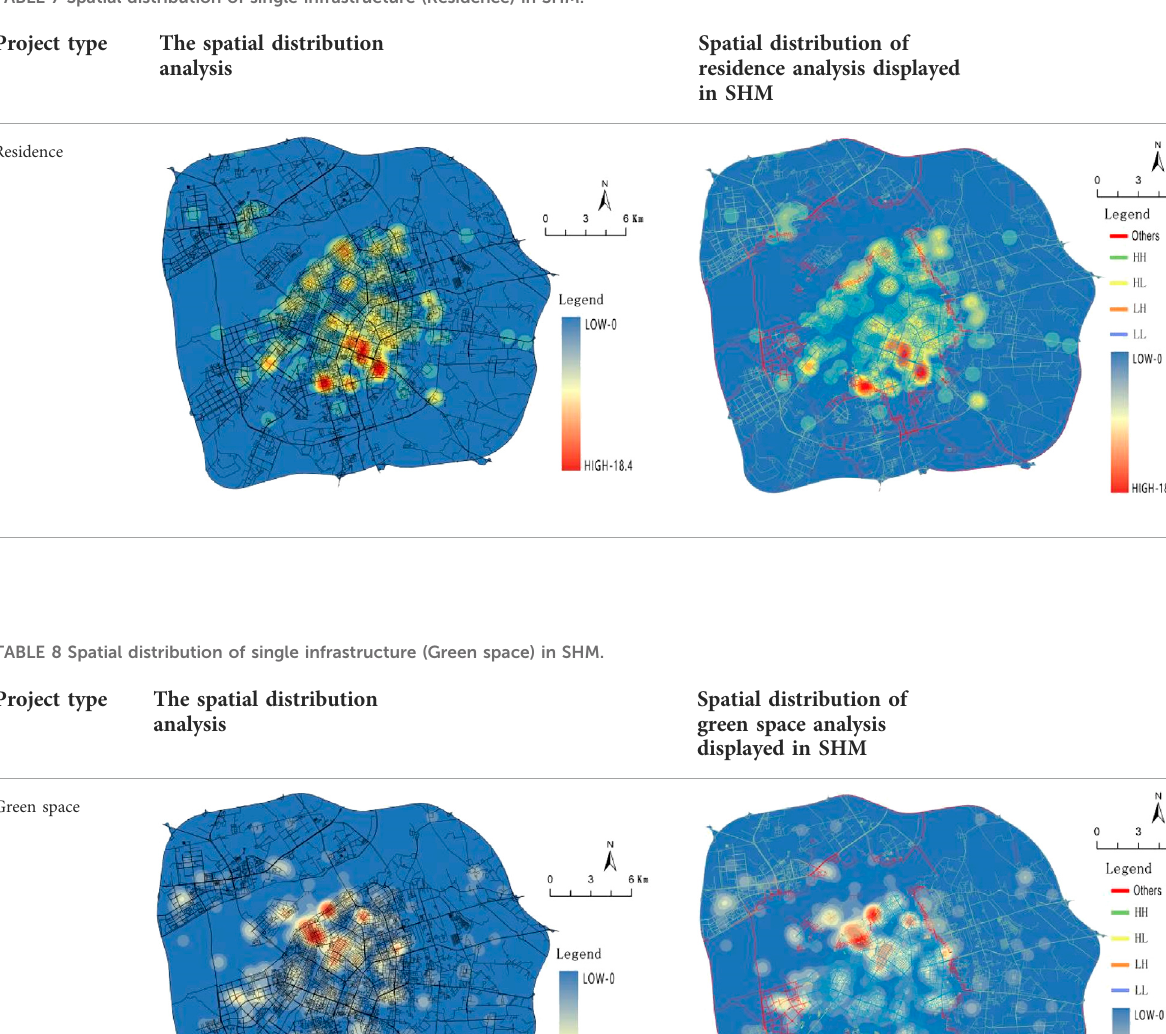
TABLE 7 Spatial distribution of single infrastructure (Residence) in SHM.